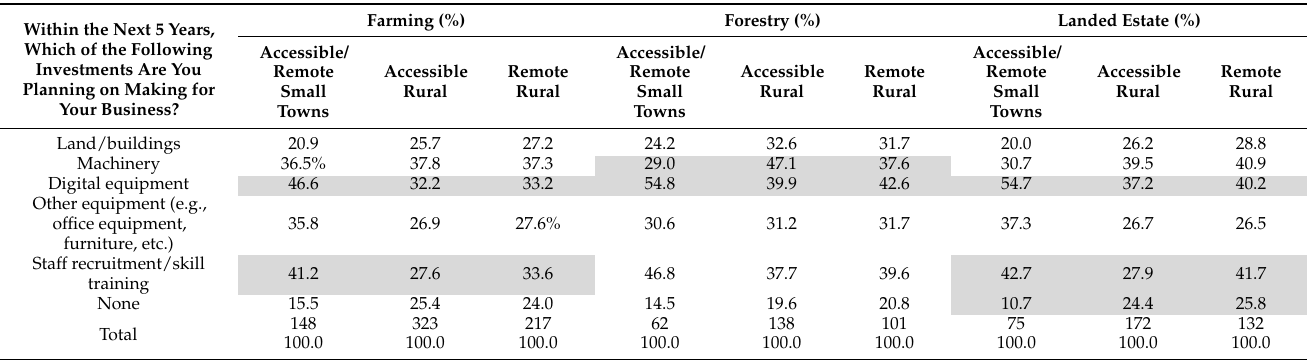
Table 6. Comparative analysis of future plans among non-land-based businesses in different rural town classifications.